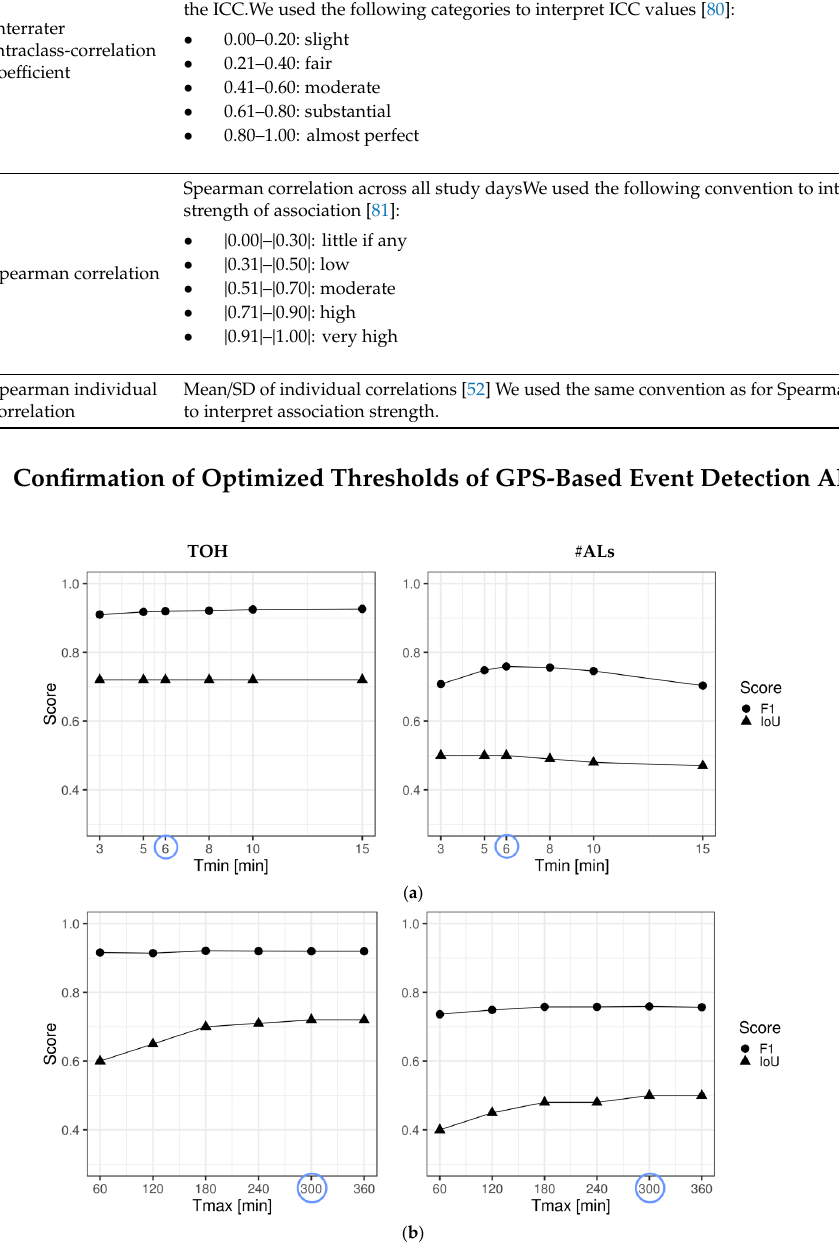
Figure A4. Confirmation of optimized thresholds by reverse stepwise iteration of Tmin and Tmax . ( a ) Confirmation of Tmin based on optimized Tmax = 300 min and Dmax = 125 m. ( b ) Confirmation of Tmax based on optimized Dmax = 125 m and Tmin = 6 min.